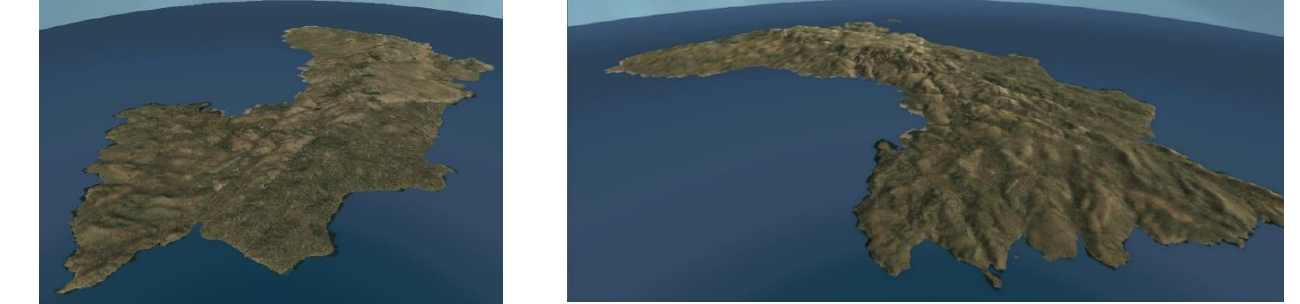
Figure 6. Terrain texturing using satellite images.